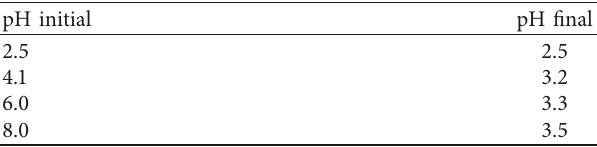
Figure 10: Effect of the initial pH on cobalt adsorption using 10g/L, (cid:30) MCSG60A. Conditions: [Co 2+ ] dosage 12.5g/L, particle size (cid:30) Table 3: Result of the pH evolution during the Co 2+ adsorption experiments.